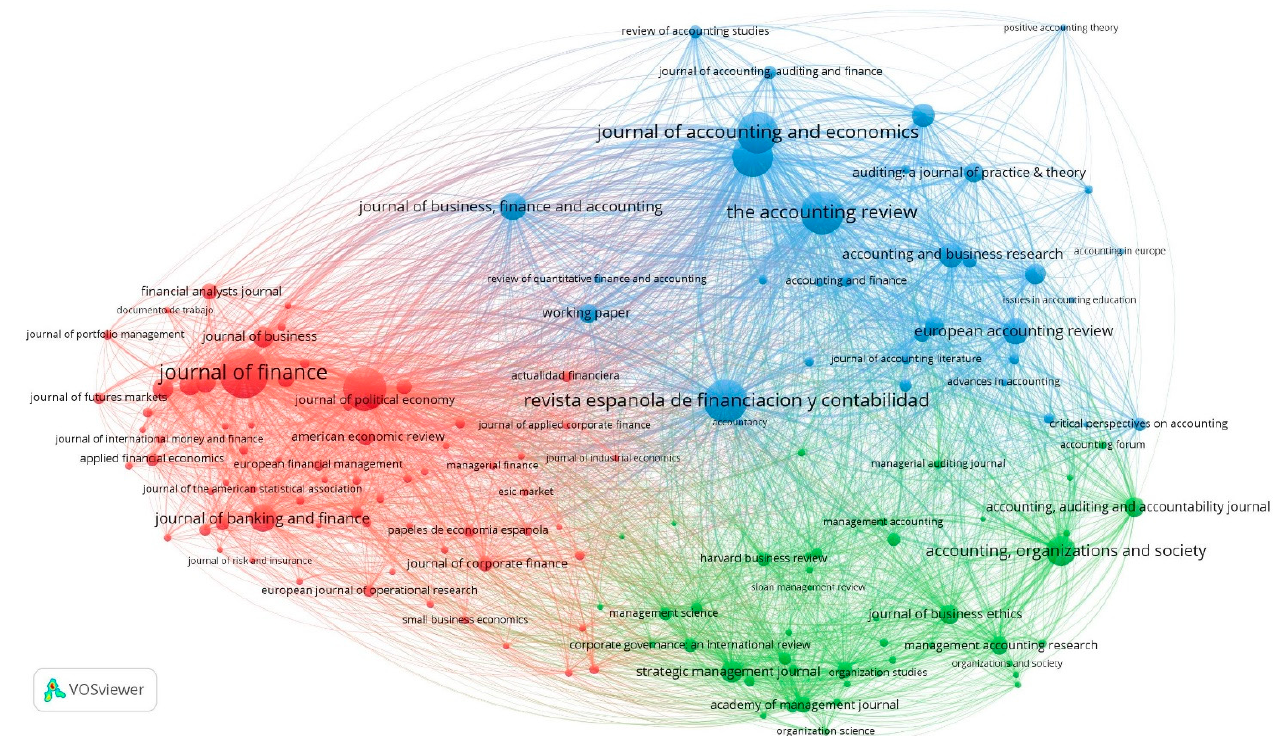
Figure 7. Network of Journal Co-citation on SJFA. The red cluster 1 (red) “Accounting and Economics for Business”, representing 70